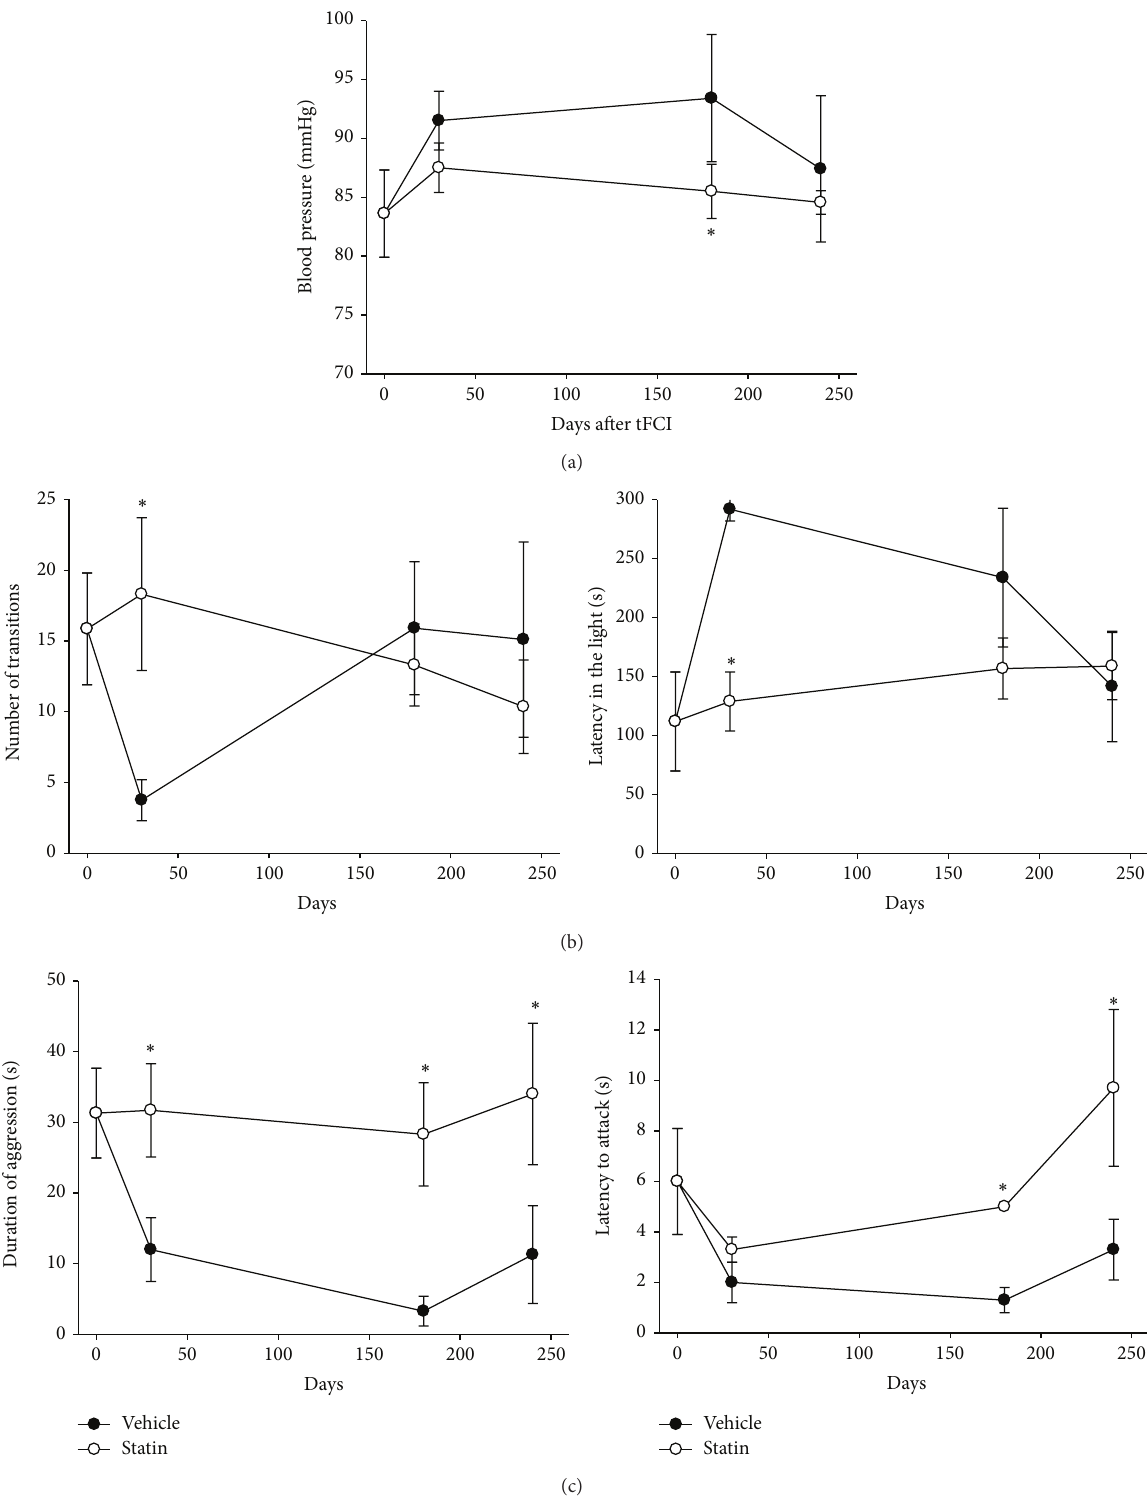
Figure 5: Physiological recovery and behavioral tests relating to the NA circuitry. (a) Profiles of blood pressure in vehicle-treated or atorvastatin-treated mice after tFCI. (b) Effects of atorvastatin on behavioral parameters in the light/dark test. The light/dark test was performed at 30, 180, and 240 days after tFCI in mice. The effect on mouse behavior in the light/dark test was determined by p-test . Data presented are the mean value ± S.E.M, ∗ 𝑝 < 0.05 relative to the vehicle group. (c) Effects of atorvastatin on behavioral parameters in the aggression-intruder test in mice. Aggression-intruder test was performed at 30, 180, and 240 days after tFCI in mice. The effect on mouse behavior in the aggression-intruder test was determined by p-test . Data presented are mean value ± S.E.M, ∗ 𝑝 < 0.05 relative to the vehicle